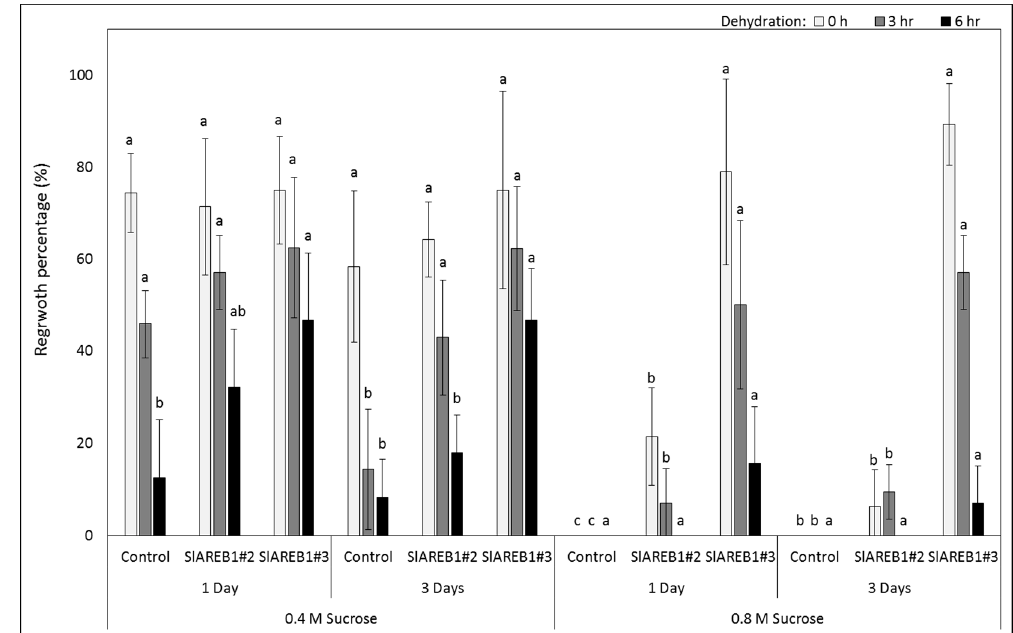
Figure 4. Regrowth percentages of encapsulated-dehydrated shoot tips of non-cryopreserved shoots tips ( − LN) of negative control, SlAREB1#2 and SlAREB1#3 transgenic tomato plants as affected by air dehydration duration after pretreatment with 0.4 and 0.8 M sucrose concentration for one or three days (values are the mean ± SD). Based on Tukey ′ s HSD test, different letter indicates significant difference among transgenic lines ( p < 0.05) for each combination of sucrose concentration, number of days, and air dehydration duration.